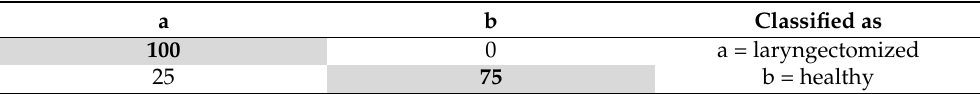
Table 13. Error matrix for the classification of the third phonetic segment. Used k-NN, cross-validation method (k = 10). General recognition